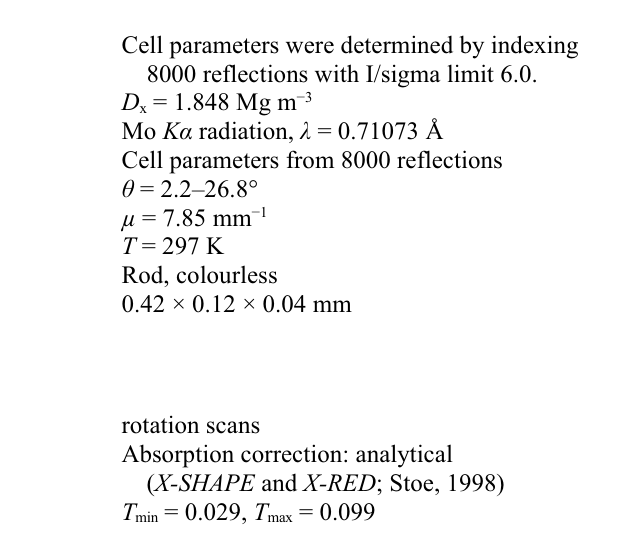
sup-2 Acta Cryst. (2008). E 64 , m196